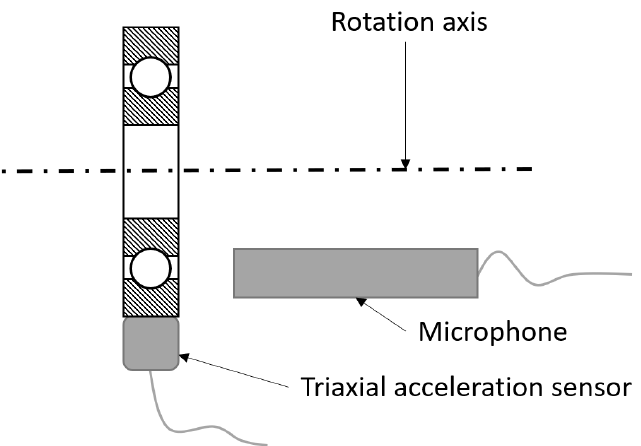
Figure 5. Scheme of the measuring concept.